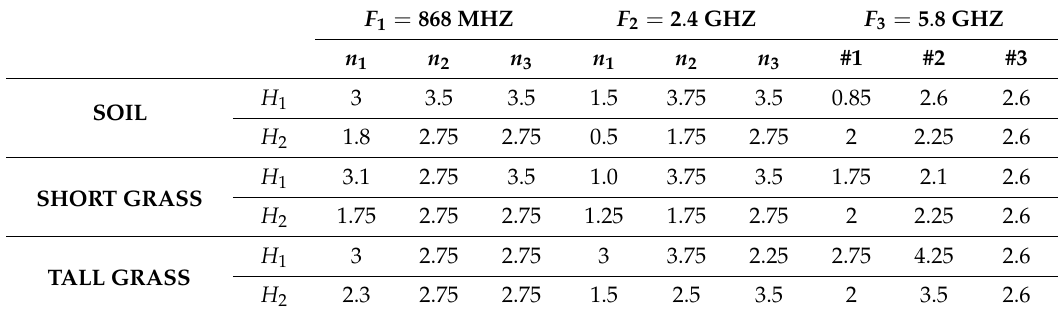
Table 2. Attenuation factors for the path loss model proposed in (5)–(7).